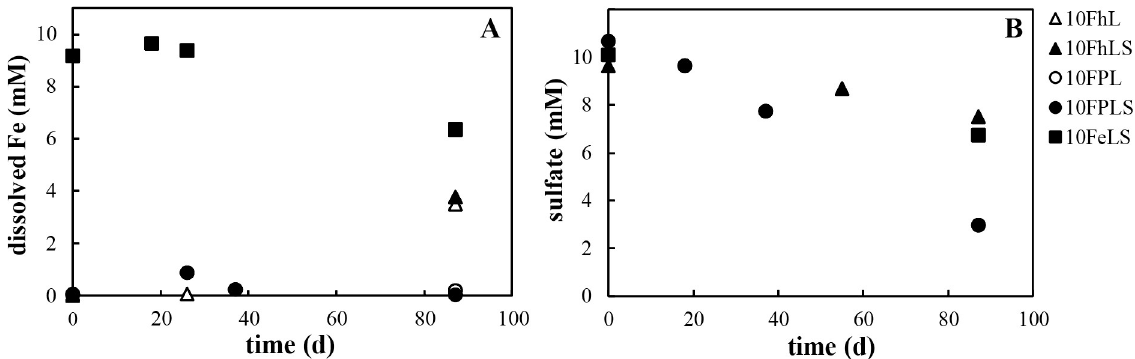
Fig 4. Dissolved iron and sulfate concentrations in Lake Pavin enrichment cultures. (A) Dissolved Fe was measured in cultures amended with different iron phases (ferrihydrite, Fe(III)-phosphate, or Fe 2+ ), lactate, and with or without added sulfate. (B) Sulfate consumption was monitored in cultures with added sulfate